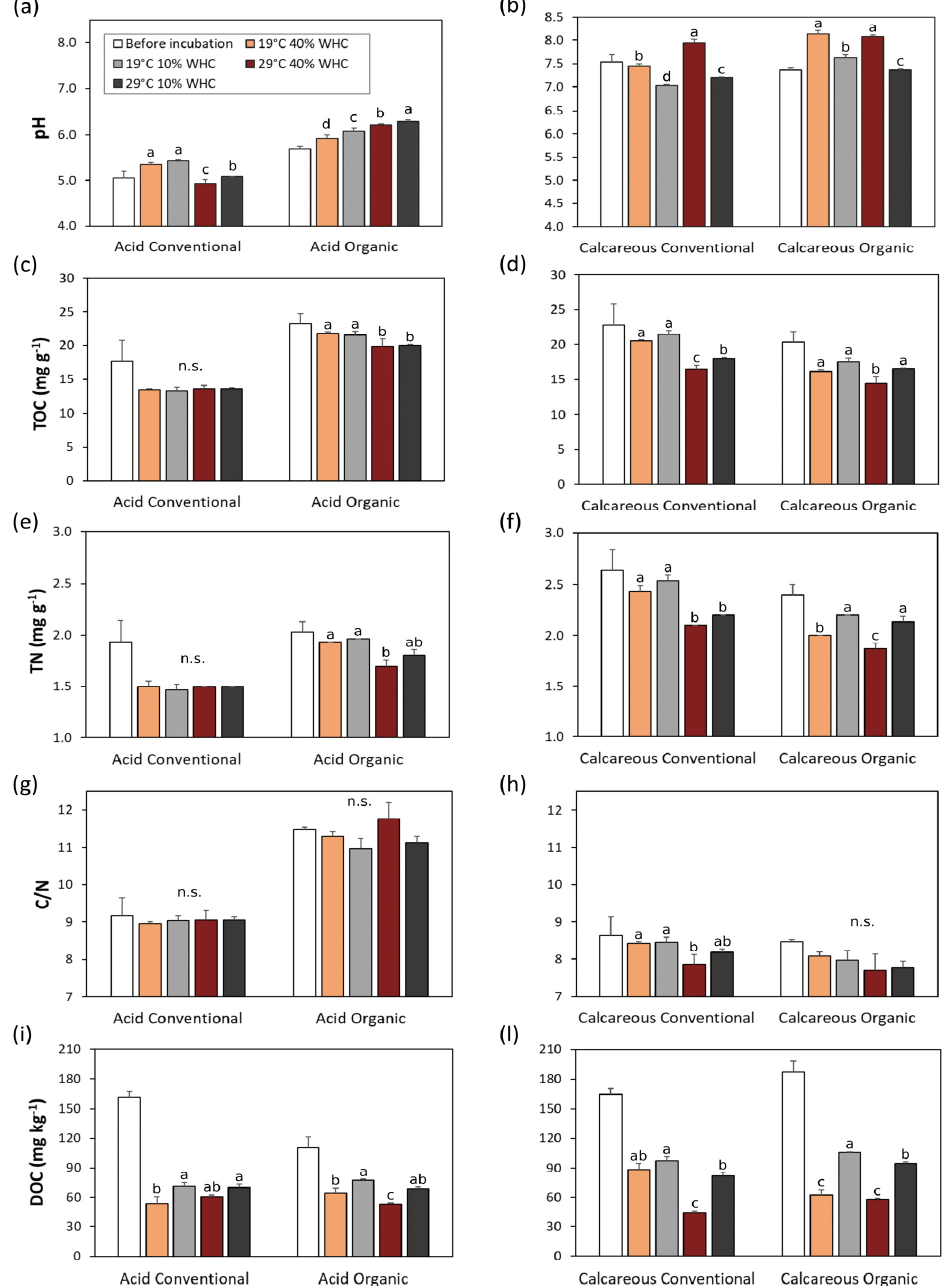
Figure 1. Soil pH, total organic carbon (TOC), total nitrogen (TN), C/N ratio, and dissolved organic carbon (DOC) in soils before and after 6 months’ incubation under no stress (19 °C and 40% WHC), moisture (19 °C and 10% WHC), temperature (29 °C and 40% WHC), and combined stresses (29 °C and 10% WHC). Different letters denote significant differences between treatments within each soil type and management, according to Tukey’s multiple comparison test ( p < 0.05).